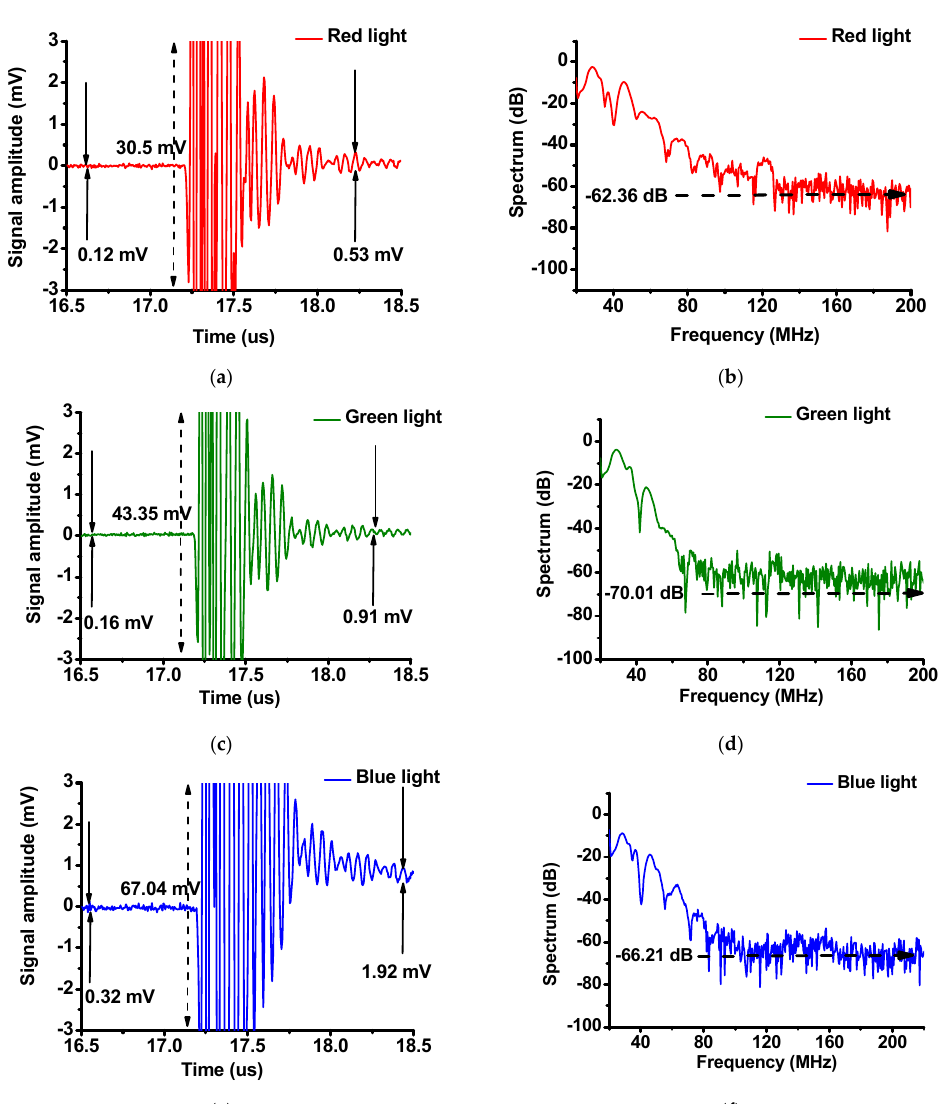
Figure 9. ( a ) Enlarged pulse echo responses and ( b ) their normalized spectra for the red LED lights, ( c ) enlarged pulse echo responses and ( d ) their normalized spectra for the green LED lights, and ( e ) enlarged pulse echo responses and ( f ) their normalized spectra for the blue LED light.